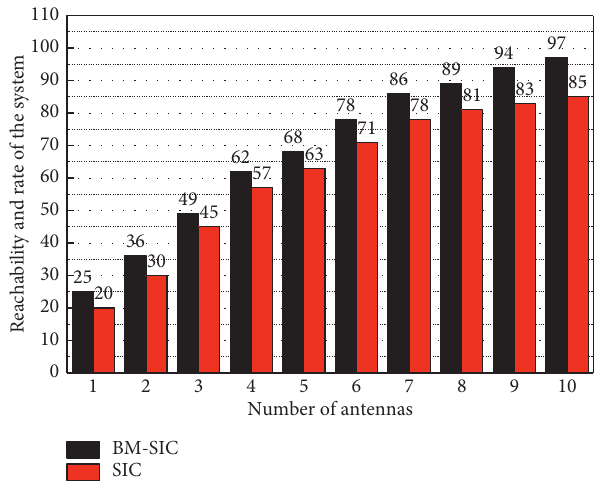
Figure 4: Average system reaches and rate